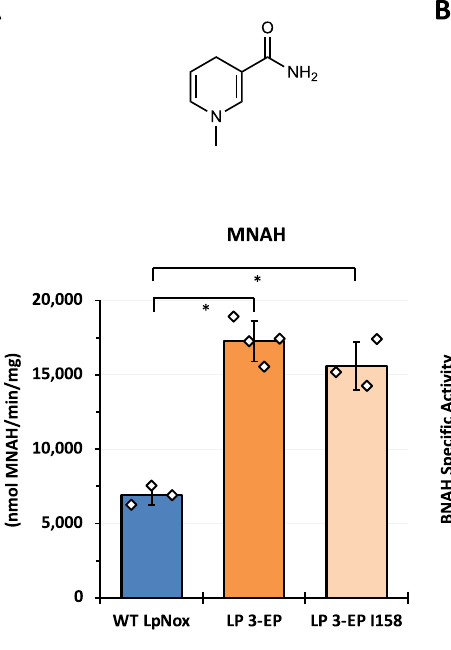
Fig. 4 | Enzymatic speci fi c activities of engineered Lp Nox variants towards otherbiomimeticcofactors.A ComparedtoWT Lp Nox(blue),engineered Lp Nox variant, LP 3-EP (orange), displayed ~2.5-fold higher activity towards MNAH. With- outtheI158Smutationtoformthehydrogenbondwiththephosphate,LP3-EPI158 (beige) still shows similar MNAH activity suggesting that the remaining mutations function allosterically since they should not have direct contact with the binding pose of MNAH. For LP 3-EP, n =4 biologically independent replicates. For other samples, n =3 biologically independent replicates. For statistics, WT to LP 3-EP,